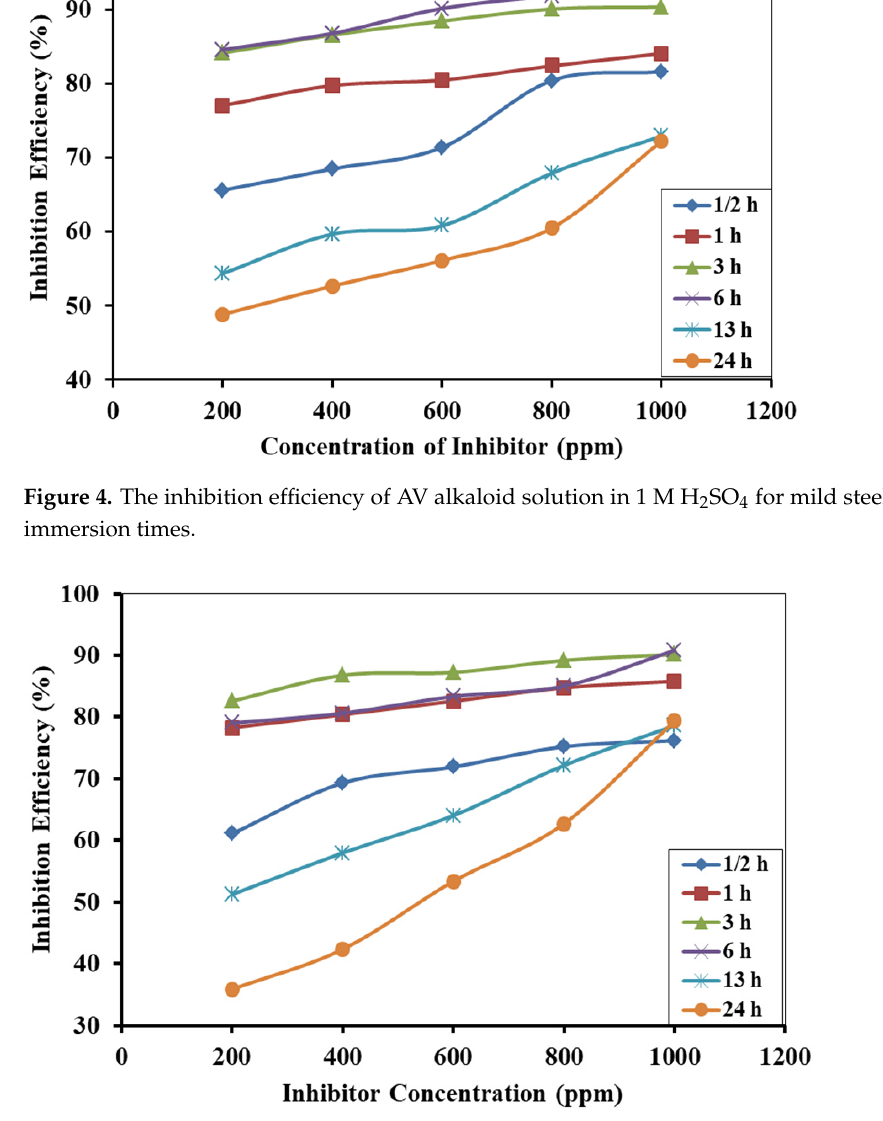
Figure 5. The inhibition efficiency of ST alkaloid solution in 1 M H 2 SO 4 for mild steel at different immersion times.